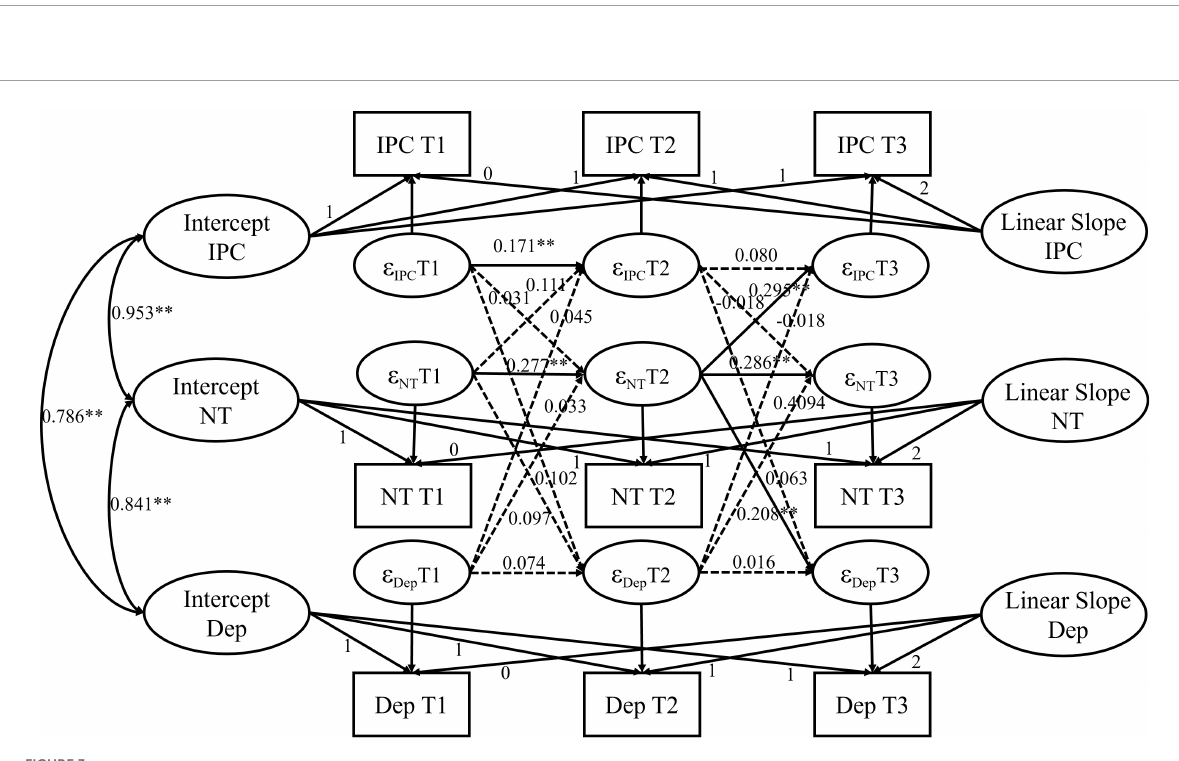
FIGURE3 Autoregressive latent trajectory model with structured residuals (ALT-SR) for children’ perception of interparental conflict, negative thinking and depression symptoms. For simplicity, covariables (sex, age T1 , and SES) correlations are not shown. IPC, interparental conflict; NT, negative thinking; Dep, depression symptoms; ∗∗ p <